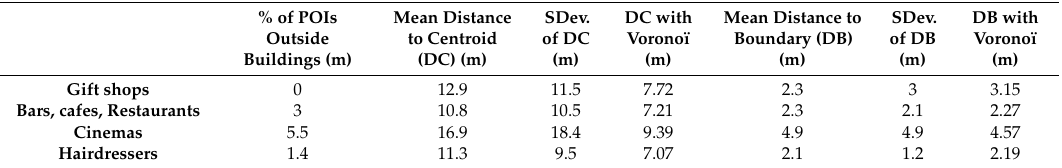
Table 3. Summary of the amenities’ locations consistency in buildings that contain at least three POIs.